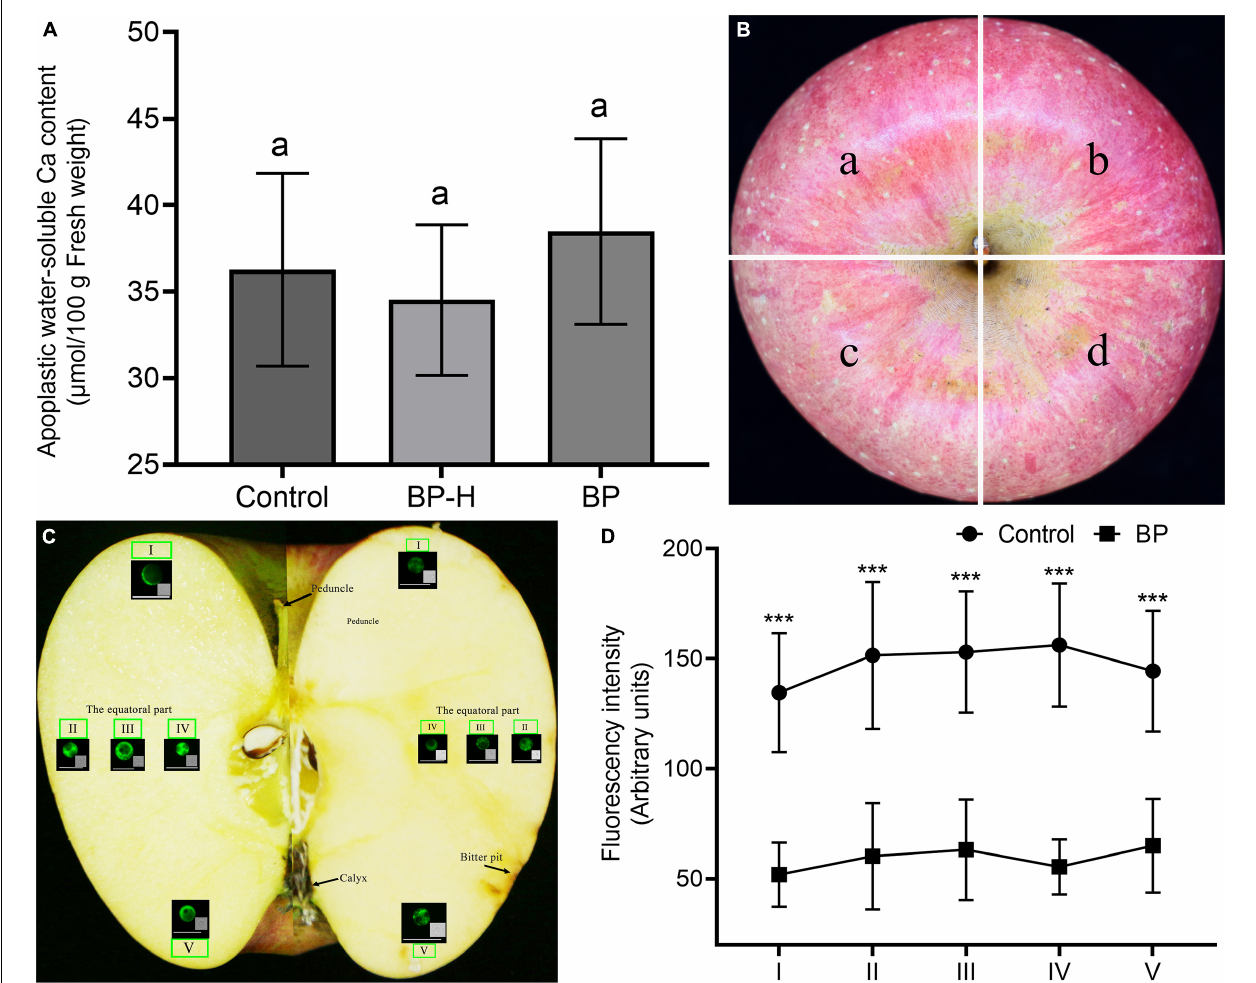
FIGURE 4 | Apoplastic water soluble and cytoplasmic Ca 2 + . (A) The concentrations of water-soluble Ca 2 + in different pulps near the calyx of fruit were compared. Data are represented as mean ± SE. The same letters indicate no significant difference ( α = 0.05). Control, healthy fruit; BP-H, healthy pulp of bitter pit fruit; and BP, bitter pit fruit. (B) The image on the left shows a healthy fruit and that on the right shows a fruit with bitter pit disorder. The apple was divided into four sections on average. (C) Five pulp portions from each fruit section from near the peduncle to the calyx were sampled, and the pulp cell protoplasts were isolated, as shown in panels I, II, III, IV, and V. Fluorescent staining of cytoplasmic Ca 2 + in apple fruit tissues from near the peduncle to near the calyx. Panels I–V show representative fluorescence images of protoplasts. (D) Ca 2 + distribution in healthy fruit and bitter pit fruit. Seven healthy and bitter pit fruits were analyzed each. The number of healthy fruit protoplasts analyzed in each fruit section was as follows: I, n = 105; II, n = 92; III, n = 133; IV, n = 136; V, and n = 124. The number of bitter pit fruit protoplasts analyzed in each fruit section was as follows: I, n = 131; II, n = 142; III, n = 165; IV, n = 129; and V, n = 103. Values are presented as mean ± SE. ***Significant difference ( P < 0.001). Control, healthy fruit; BP, bitter pit fruit. The magnification of the objective of the microscope is 20